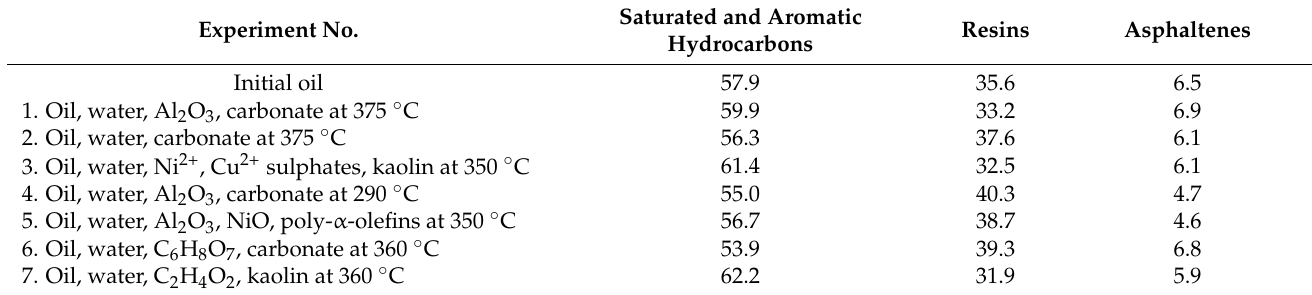
Table 2. Component composition of the initial and hydrothermally converted oil. Experiment